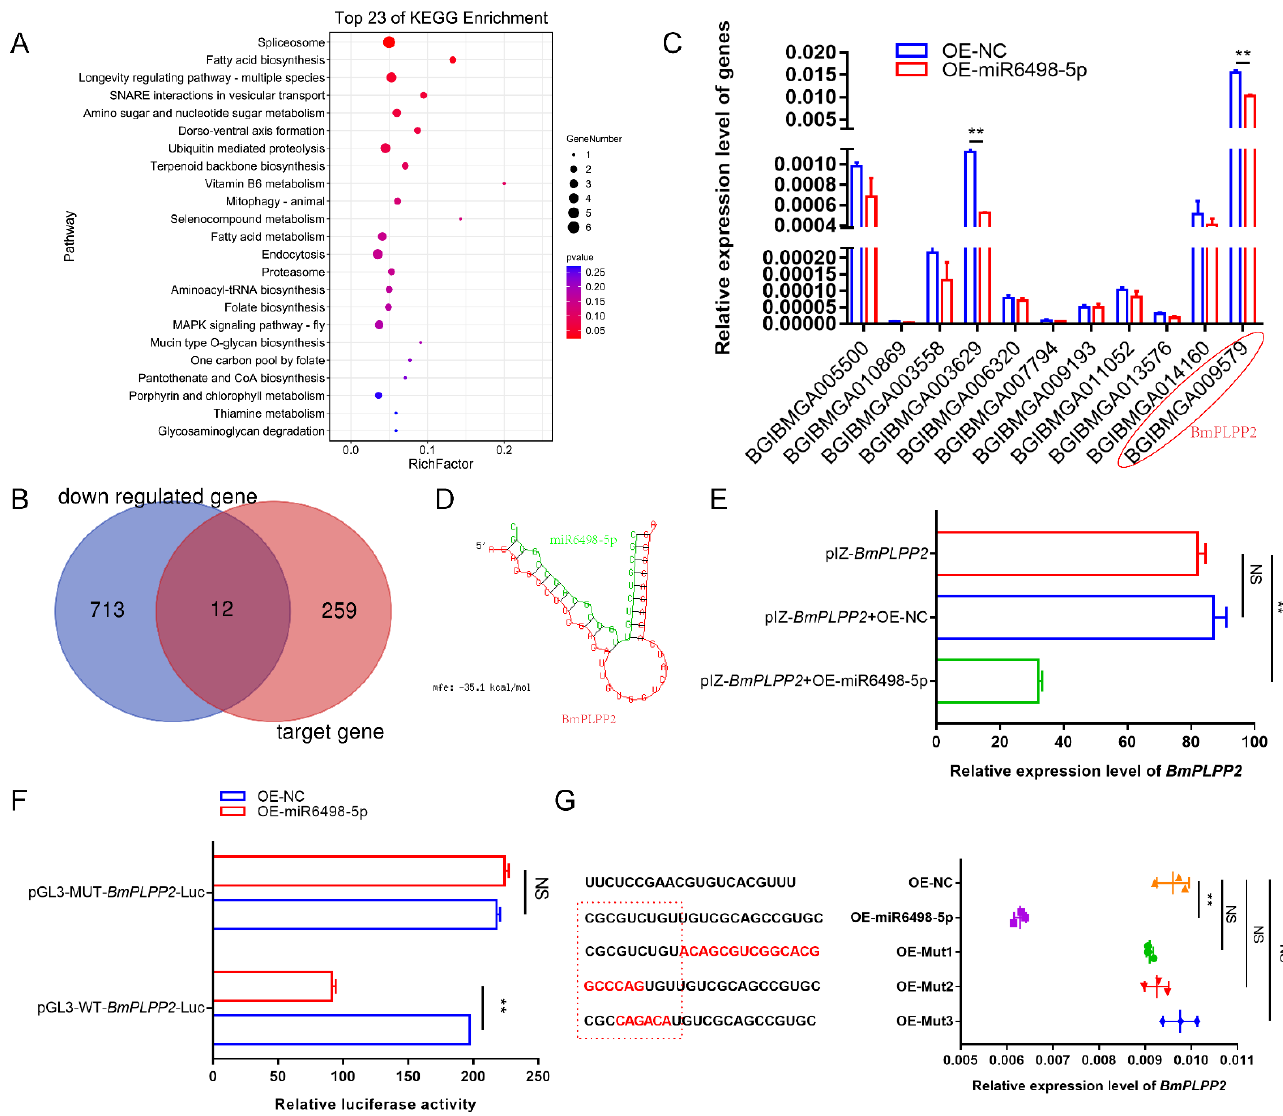
Figure 5. Identification of how miR6498-5p negatively regulates BmPLPP2 ( A ) KEGG enrichment analysis of the target genes of miR6498-5p predicted by miRanda-3.3a. ( B ) Venn diagram depicting the genes targeted by miR6498-5p and significantly downregulated by N. bombycis infection. ( C ) Expression of 12 genes obtained from the Venn diagram in BmE cells transfected with an OE-miR6498-5p vector. ( D ) The predicted binding structure of miR6498-5p with BmPLPP2 by RNA22. Green represents the miRNA, and red represents the mRNA. ( E ) qPCR analyzes the expression of BmPLPP2 in BmE cells by co-transfection with the expression vectors of BmPLPP2 and miR6498-5p ( F ) Dual luciferase assay analysis of the binding of miR6498-5p to the BmPLPP2 . ( G ) qPCR analyzes the expression of BmPLPP2 in BmE cells by transfection with the mutants of miR6498-5p. Red sequences represent mutated bases. The dotted red line box represents the seed sequence of miR6498-5p. All data represent the means of three replicates ± SD, **, p < 0.01, NS, p >